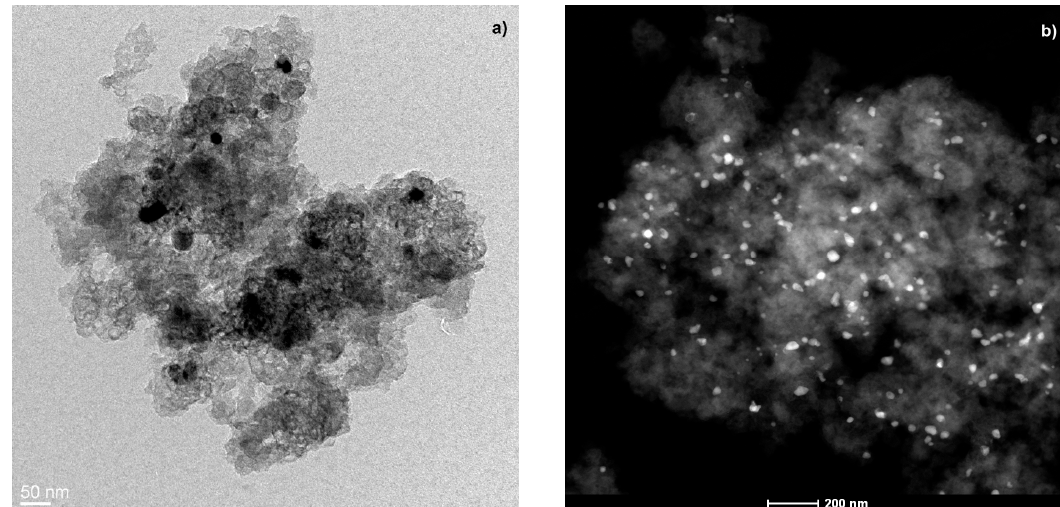
Figure 2. Transmission electron microscopy (TEM) analysis of sample ACo6: ( a ) TEM image; and ( b ) analytical electron microscopy (AEM) spectra collected in scanning transmission electron microscopy (STEM) mode using a high angle annular dark field (HAADF) detector.